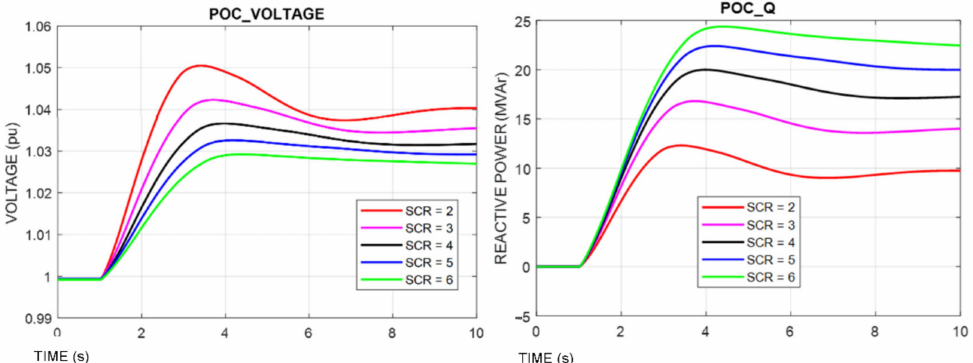
Figure 3. Result of 5% Voltage Step Test: Voltage and Q response at